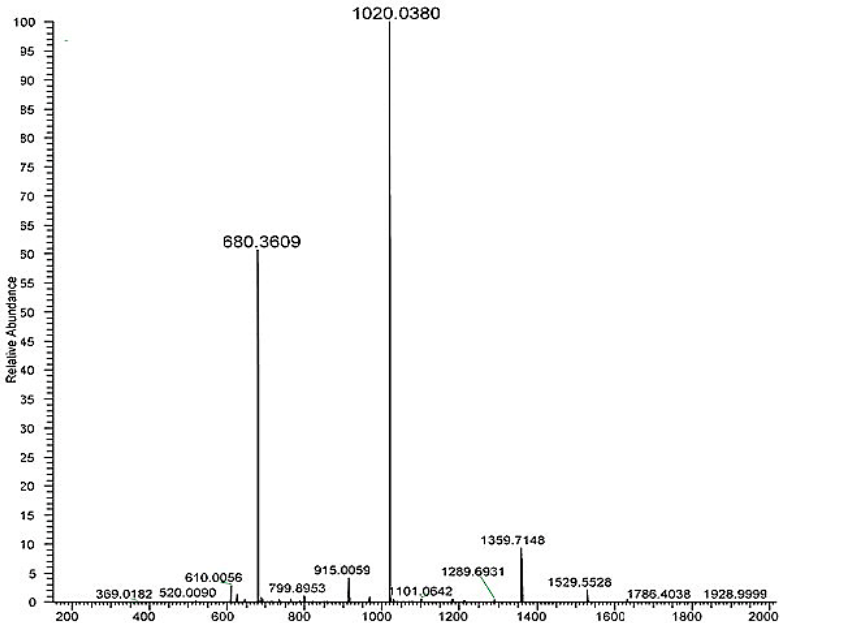
Figure 3. HRMS full scan spectra of the mono-lactosylated peptide. Relative abundance is on the y axis, mass-to-charge ( m / z ) ratio on the x axis.